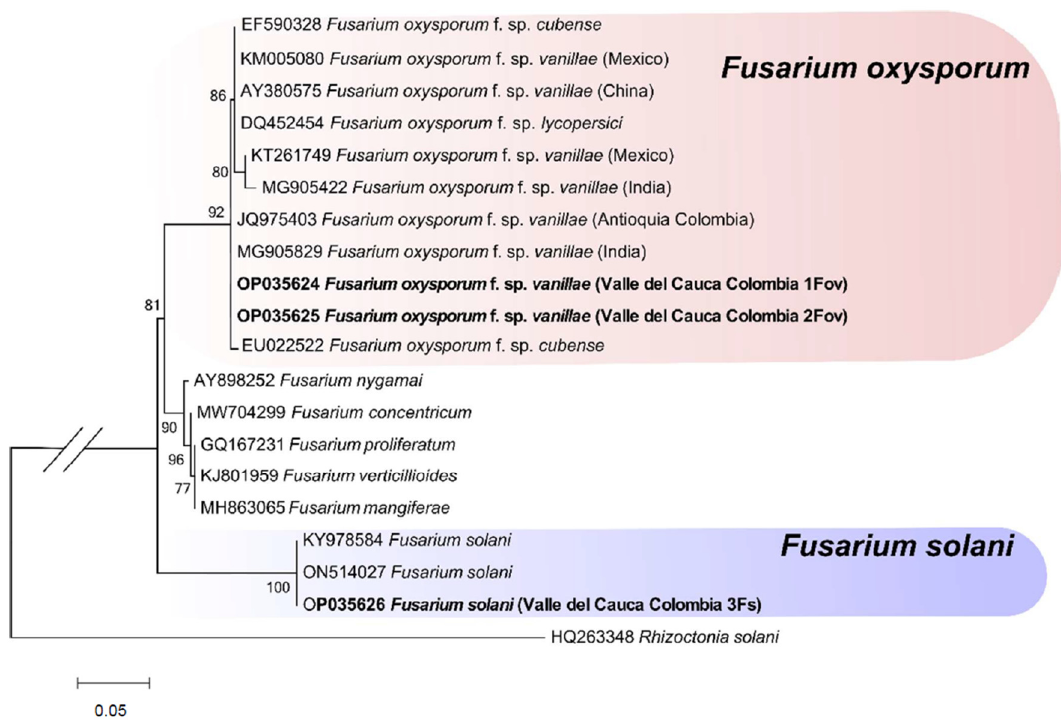
Figure 3. Phylogenetic tree obtained by the Maximum Likelihood method based on the Kimura 2-parameter model of consensus sequences of the partial Internal Transcribed spacer-ITS region of the rRNA. The sequences obtained in this study are indicated in bold. The numbers in the branches indicate a Bootstrap value ≥ 70%. The species Rhizoctonia solani was included as an